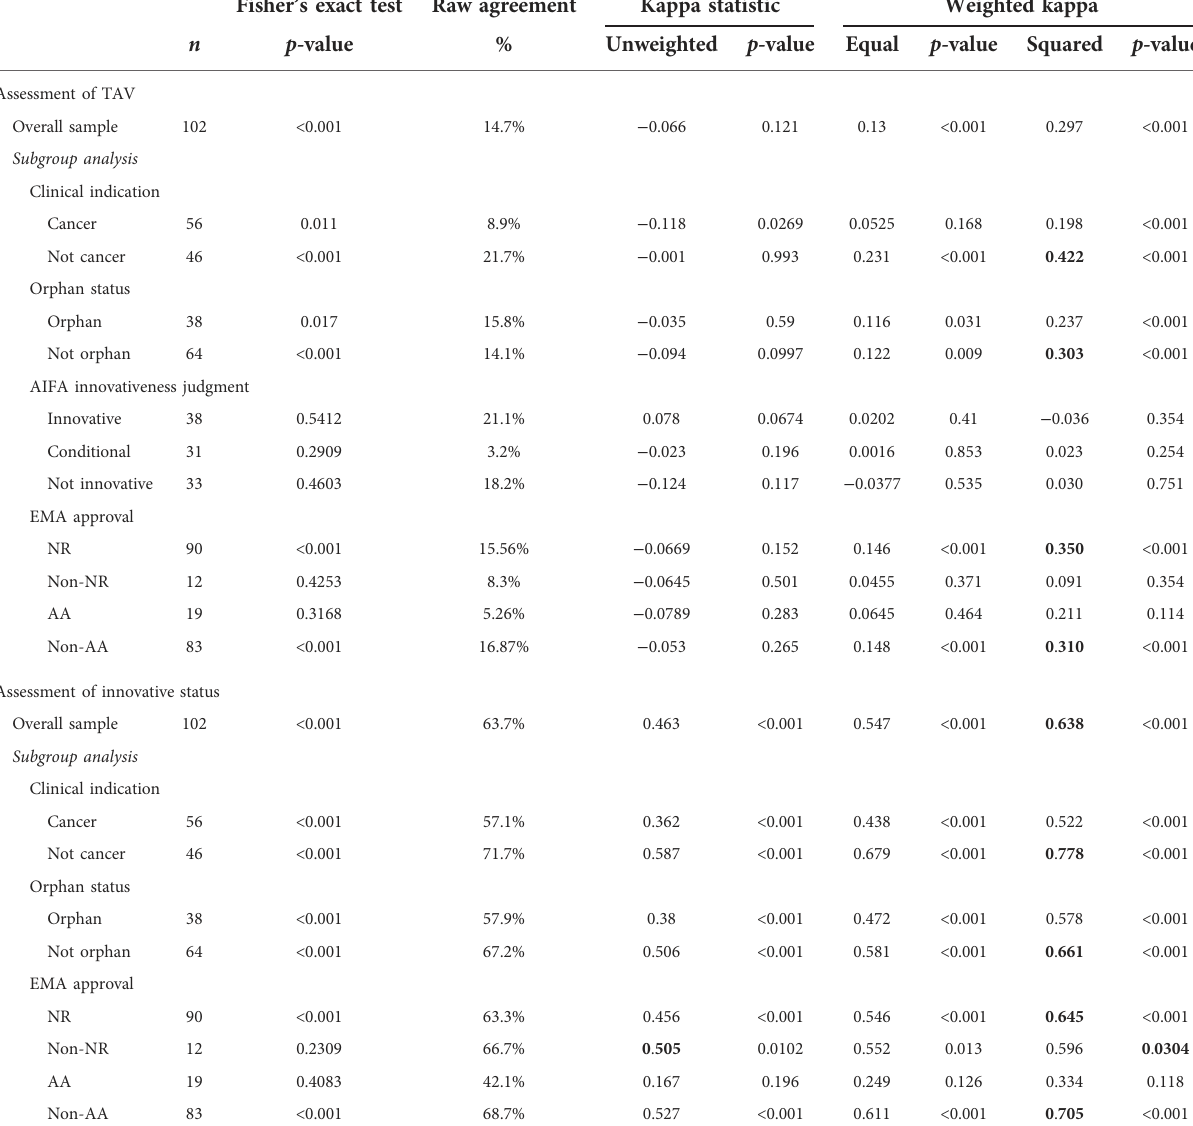
TABLE 8 Level of agreement between AIFA and HAS. Fisher ’ s exact test Raw agreement Kappa statistic Weighted